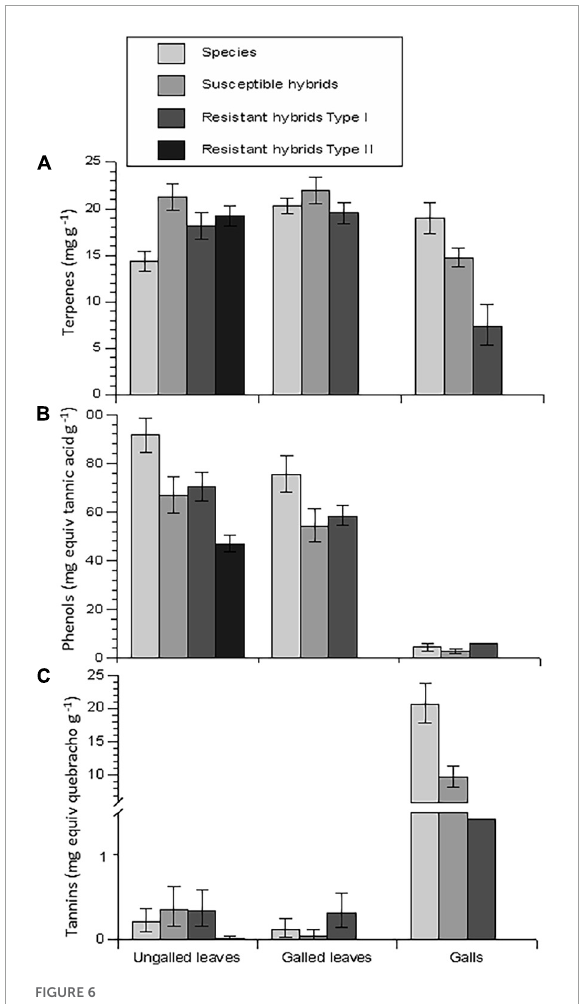
FIGURE6 Foliar concentrations (A) terpenes, (B) phenolics, and (C) condensed tannins of ungalled leaves (control leaves), galled leaves, and gall tissue of the study genotypes. There was little or no gall tissue for analysis in Resistant Types I and II. Bars represent means and error bars represent standard errors.